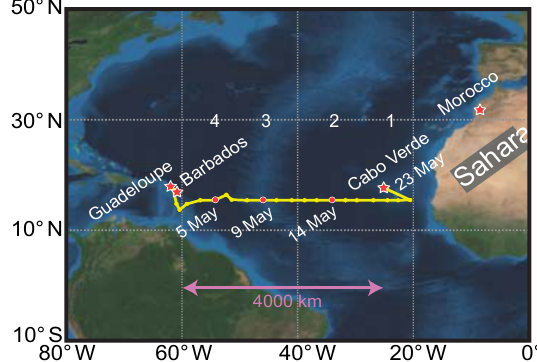
Figure 1. The cruise track of the R/V Meteor from Guadeloupe (29 April 2013) to Cabo Verde (23 May 2013) indicated as a yel- low line (Rittmeister et al., 2017). Lidar observations 1–4 (see red circles and star at Cabo Verde) representing key stages of dust layering over the remote Atlantic are discussed in detail in part 1 (Rittmeister et al., 2017) and are compared with simulated dust pro- files in Sect. 3. The locations of the lidar observations are 1000km (case 1, 23 May 2013, 03:45–05:00UTC), 1700km (case 2, 14 May 2013, 23:45–00:20UTC), 3300km (case 3, 9 May 2013, 23:15–24:00UTC), and 4300km (case 4, 5 May 2013, 23:40– 00:35UTC) west of the African